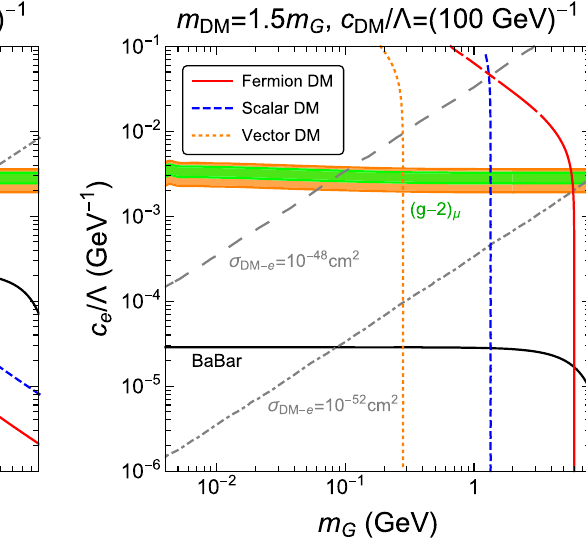
above the black lines on left and right, respectively. Contours for DM-electron scattering cross sections are shown in gray lines for σ = 10 − 44 , 10 − 48 cm 2 on left and σ = 10 − 48 , 10 − 52 cm 2 DM − e DM − e on